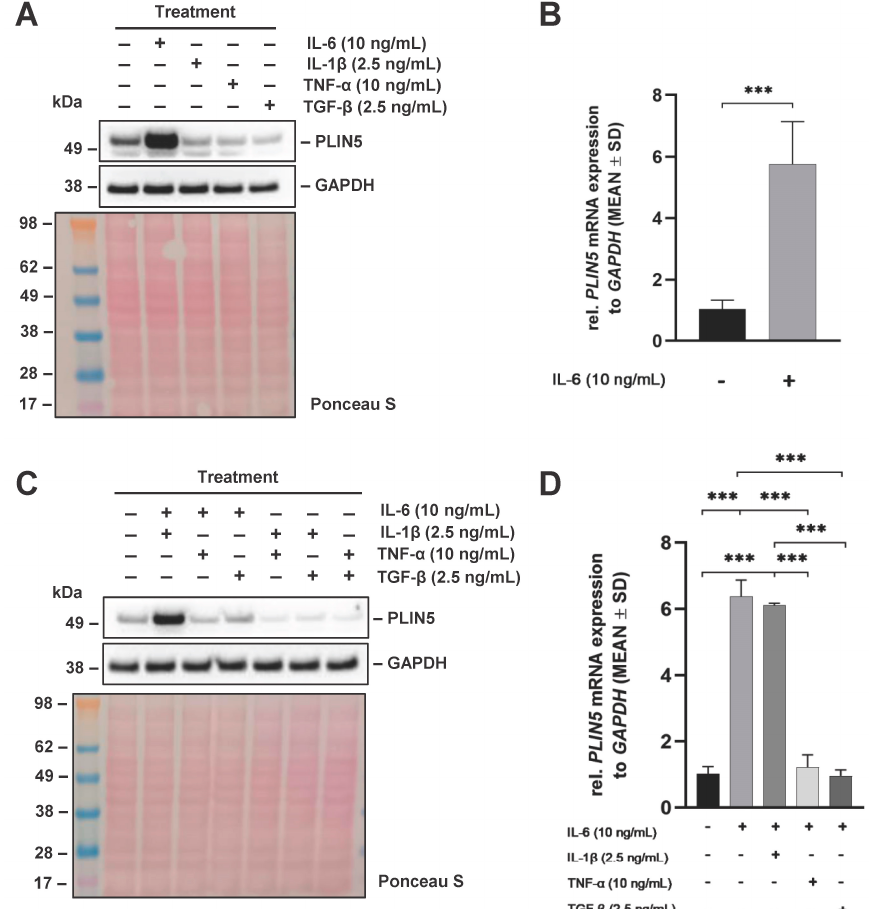
Figure 1. Differential cytokine regulation of PLIN5 expression in Hep3B cells. Hep3B cells were stimulated with the indicated concentrations of different cytokines and combinations thereof for 24